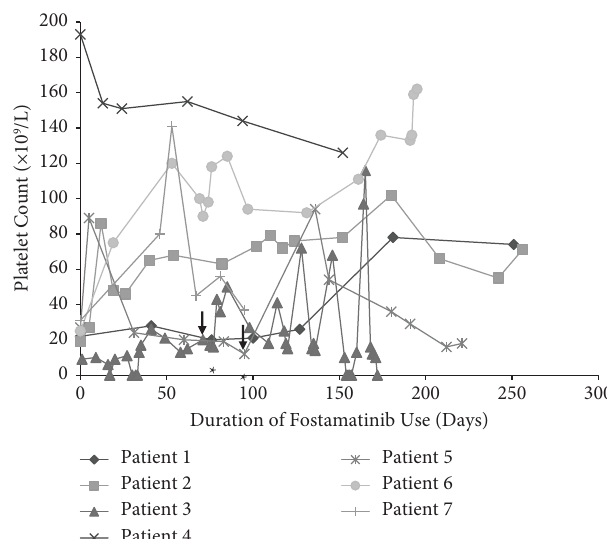
Figure 1: Platelet response to fostamatinib use over time. All patients were started on a dose of 100mg orally twice daily. A dose increase to 150mg twice daily was required in patient 3 and patient 5, denoted by the vertical arrow ( ↓ ). Te administration of rescue therapy with either dexamethasone only (patient 3) or dexa- methasone and IVIG (patient 5) is denoted by the asterisk ( ∗